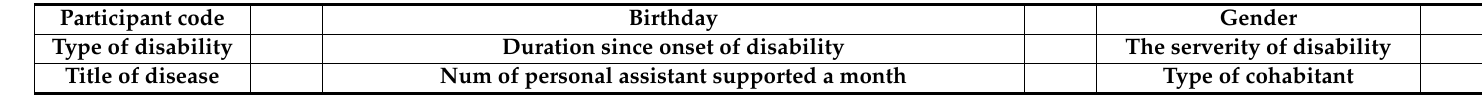
Table A1. Survey Template for Asking Utilized Facilities and Period of Use.